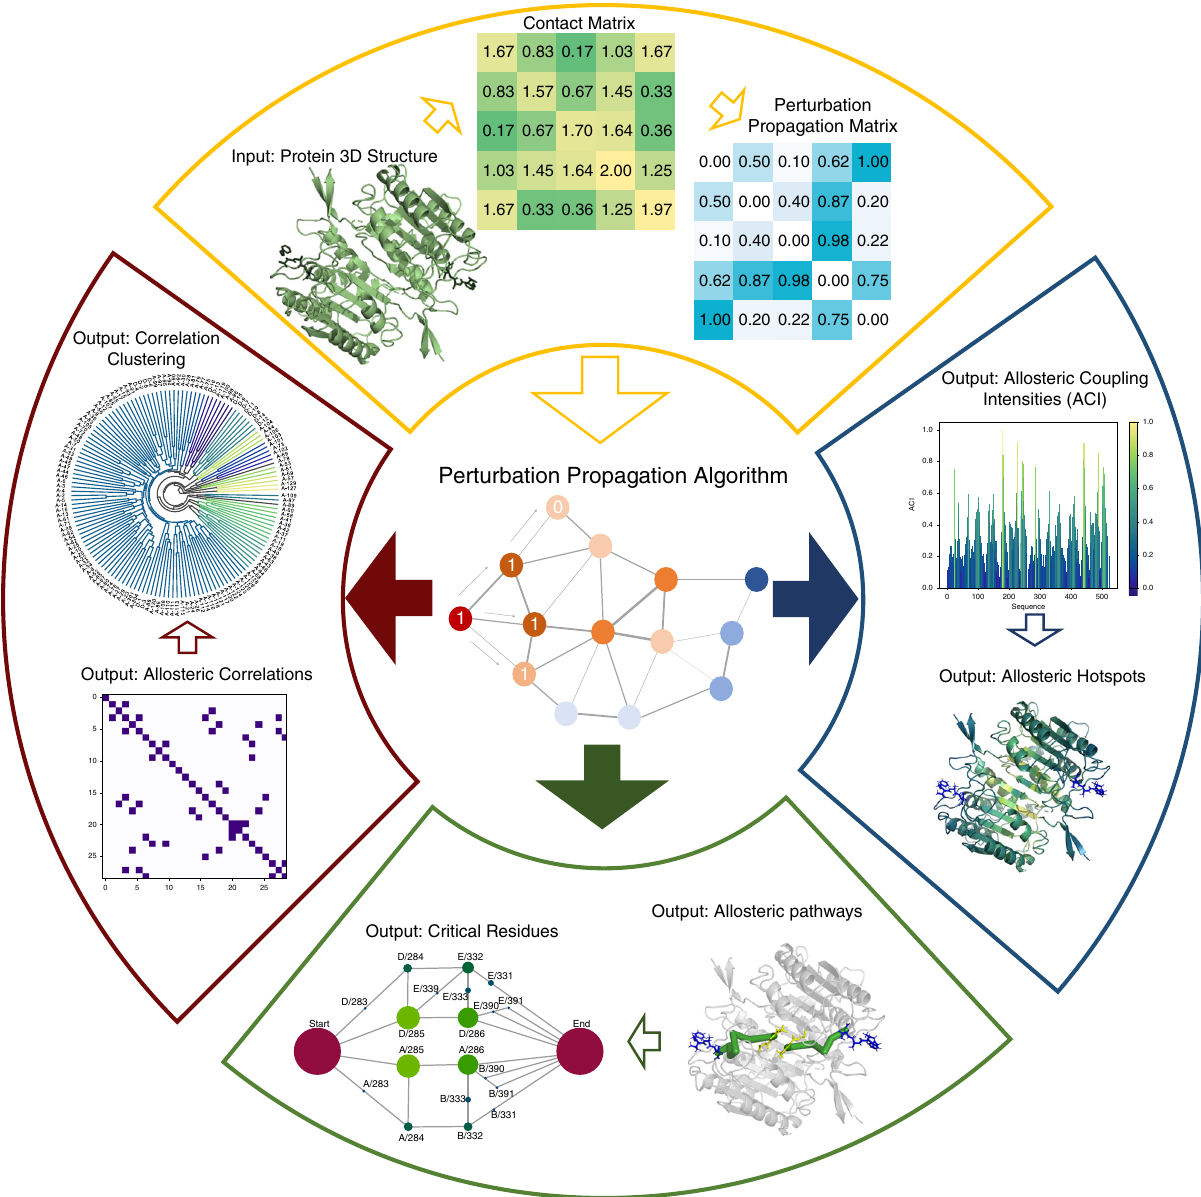
Fig. 1 The Ohm work fl ow. The Ohm work fl ow begins with input of the 3D structure of a protein. Next (moving clockwise), a contact matrix is calculated and a perturbation propagation probability matrix is generated according to Eqs. (1) – (3) ( “ Methods ” ). The perturbation propagation probability matrix provides the foundation of the perturbation propagation algorithm. If the position of the active site is known, the perturbation propagation algorithm calculates ACIs of all residues relative to the active site. We further devised a program to identify allosteric hotspots based on ACI values. If the position of both the active site and the allosteric site are known, the perturbation propagation algorithm can determine the allosteric pathways that connect the active site and the allosteric site. Further, Ohm identi fi es critical residues in allosteric pathways based on Eq. (4) ( “ Methods ” ). If neither the active site nor the allosteric site is known, the perturbation propagation algorithm can calculate allosteric correlations of each pair of residues. These correlations are then clustered to interrogate how residues in the protein are allosterically